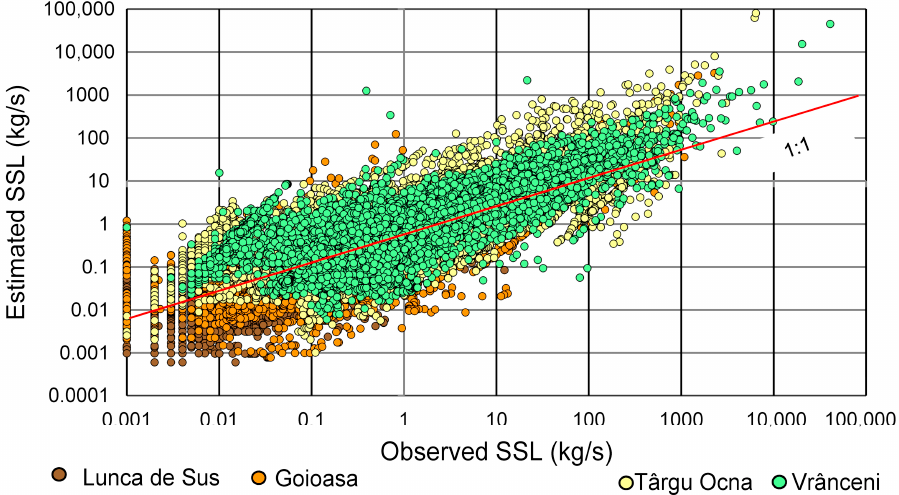
Figure 4. Scatter plot of relationship between observed and estimated suspended load at the four gauging stations along the Trotu ș River (1994–2014).